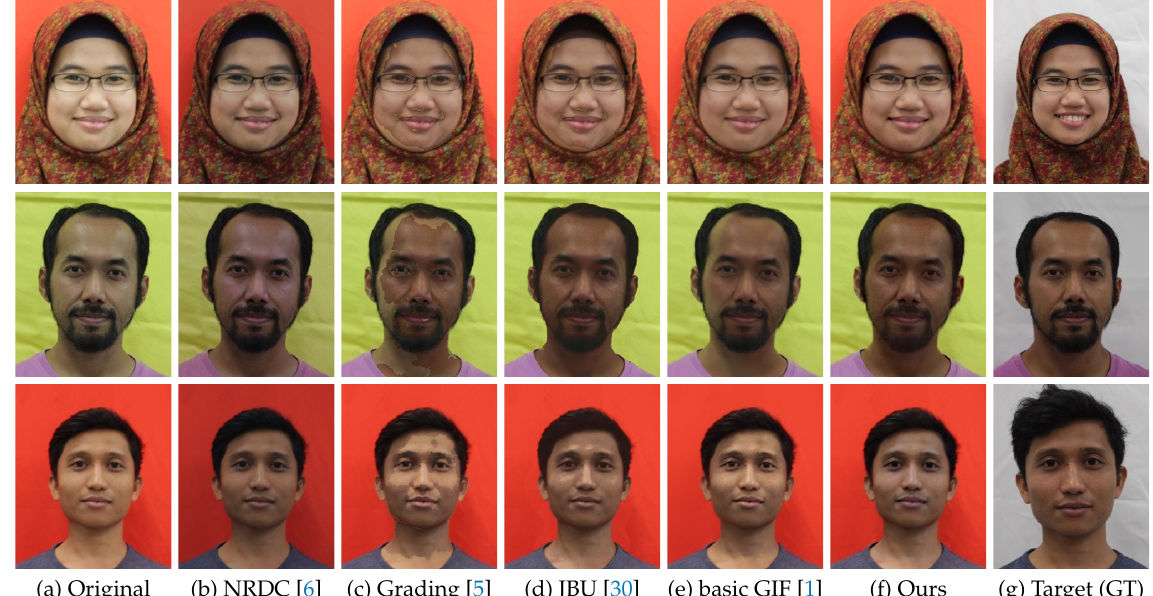
Figure 12. Comparison with the existing methods. ( a ) target; ( b ) original; ( c ) [11] with [5], ( d ) NRDC [6]; ( e ) Jaesik et al. [31], and ( f ) our method.